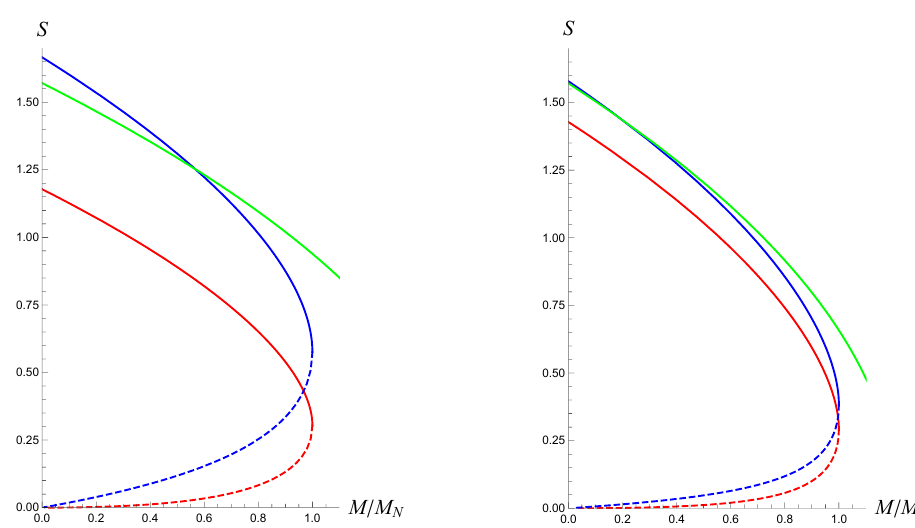
Figure 8 . Plot of S (3) gen (red), S (3) (blue) and S SdS (green) as a function of mass M . The dashed BH 3 curves refer to black hole entropies S h , while the solid curves denote the entropies associated with the cosmological horizon S c . The backreaction parameter is ν = 1 / 3 (left) and ν = 1 / 10 (right), and G 3 = R 3 = 1 . As ν → 0 , all solid curves collapse to S SdS , while the dashed curves go to zero. 3